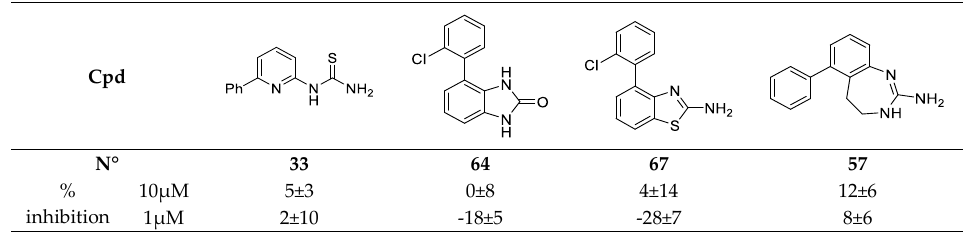
Figure 4. Structurally-related inactive compounds.